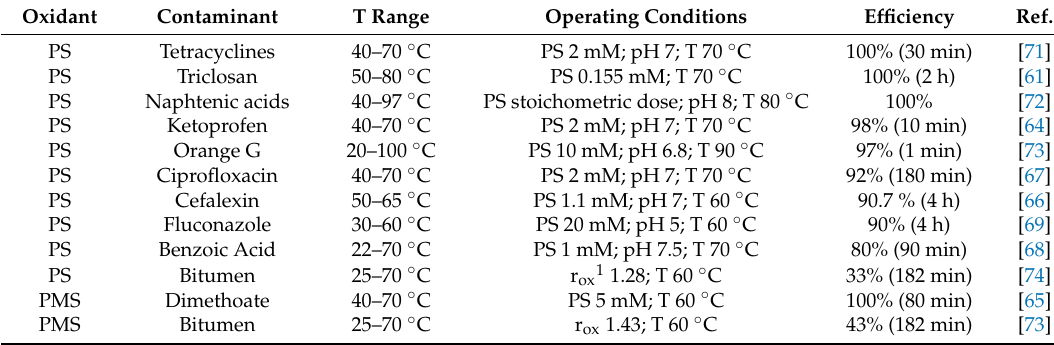
Table 5. Micropollutant removal by thermal activation of PMS and PS.